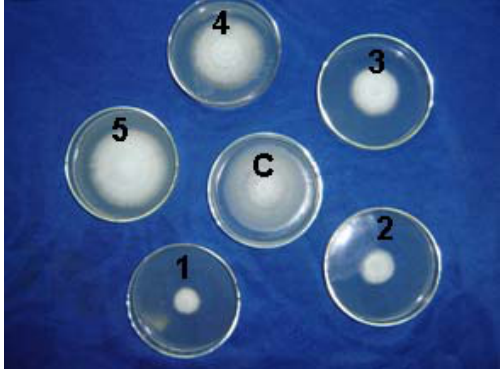
Figure 1. Effect of various concentrations of 2d on the growth of isolated hypha of F. oxysporum (100, 50, 25, 5 and 1